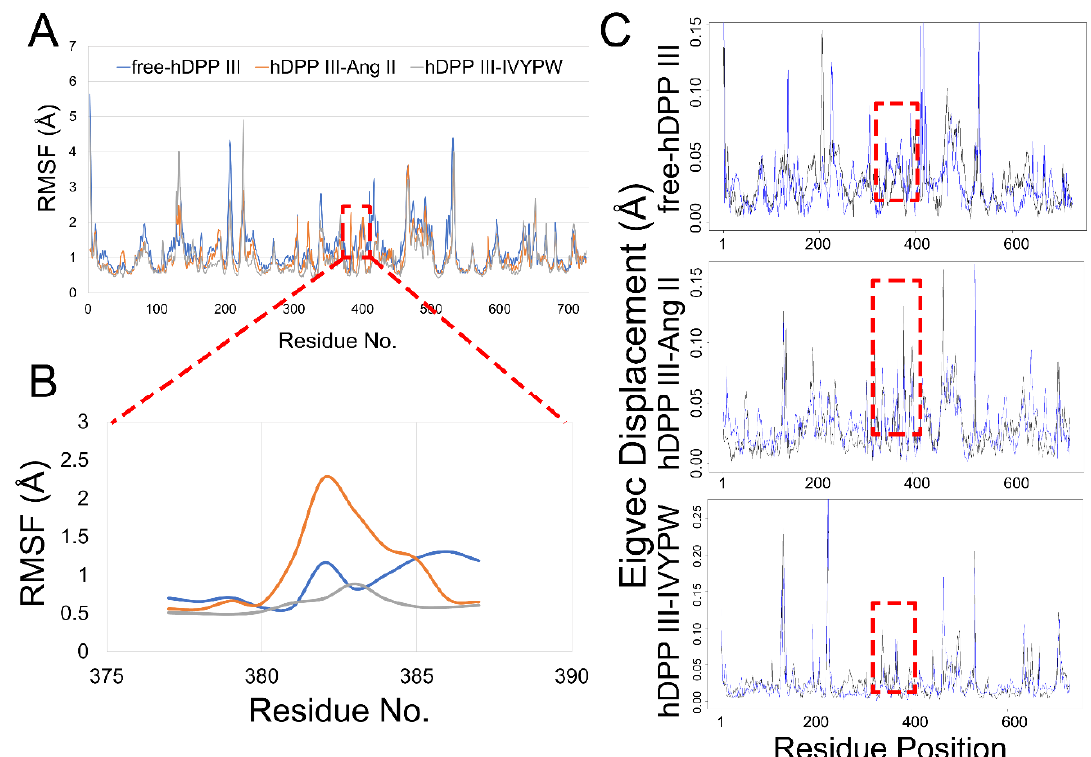
Figure 8. ( A ) RMSF plots of the three systems. ( B ) RMSF plots for the residue Thr380-Gly385 in the three systems. ( C ) Residue displacements that correspond to the motions described by the first eigenvector for free-hDPP III, hDPP III–Ang II, and hDPP III–IVYPW.